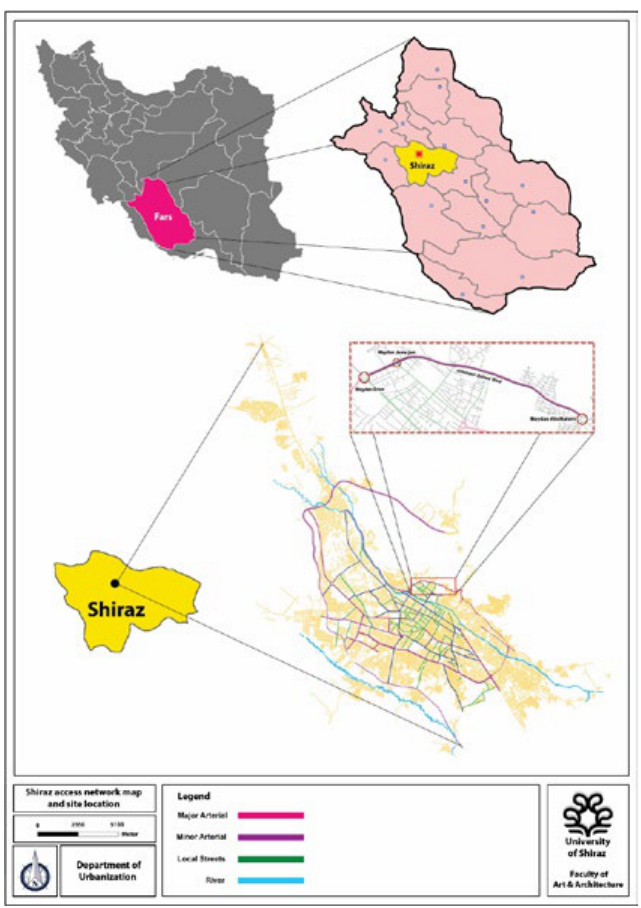
Fig. 1. Site Location of the case